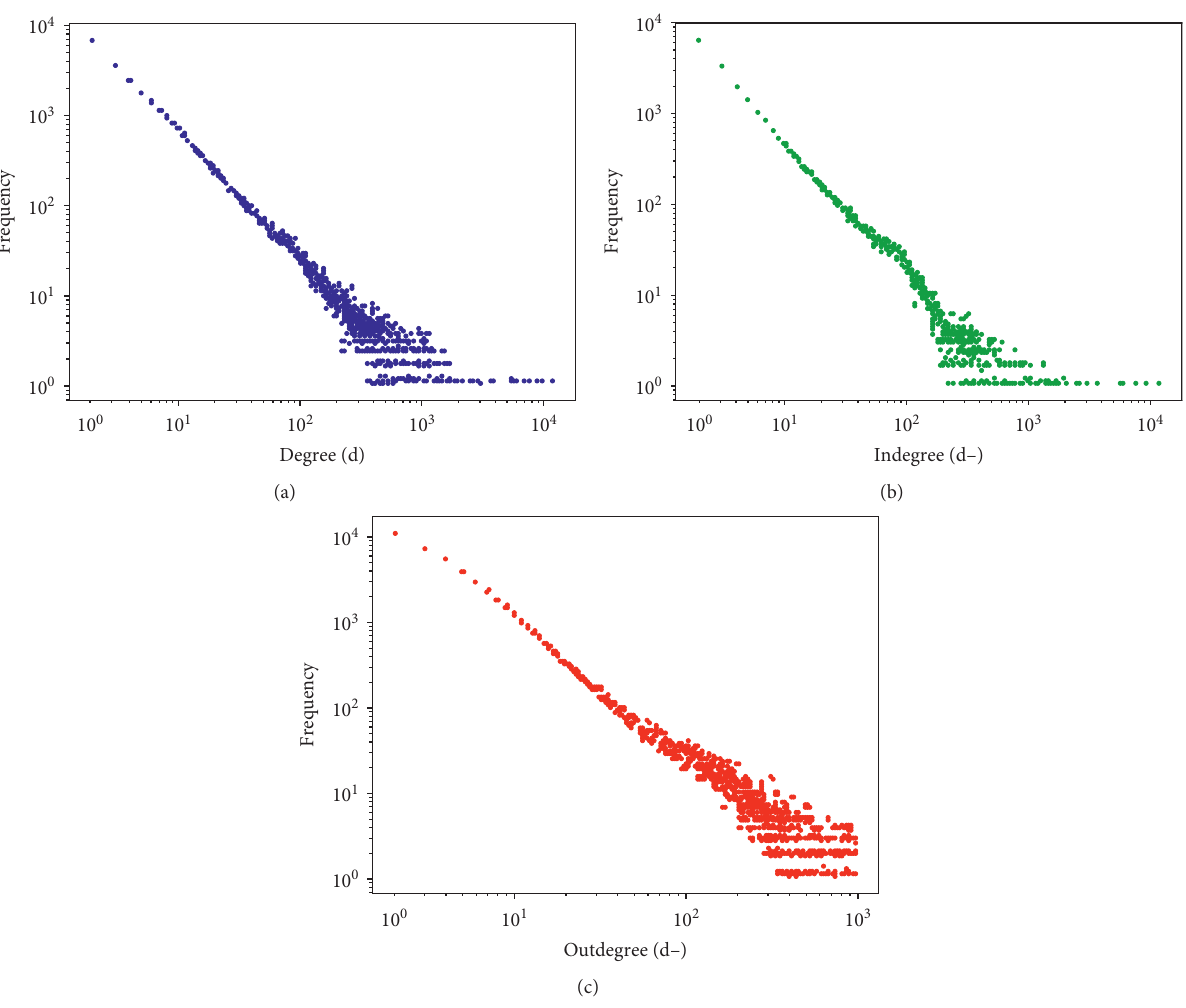
Figure 5: The degree distributions of the Weibo subnet used in the experiments.